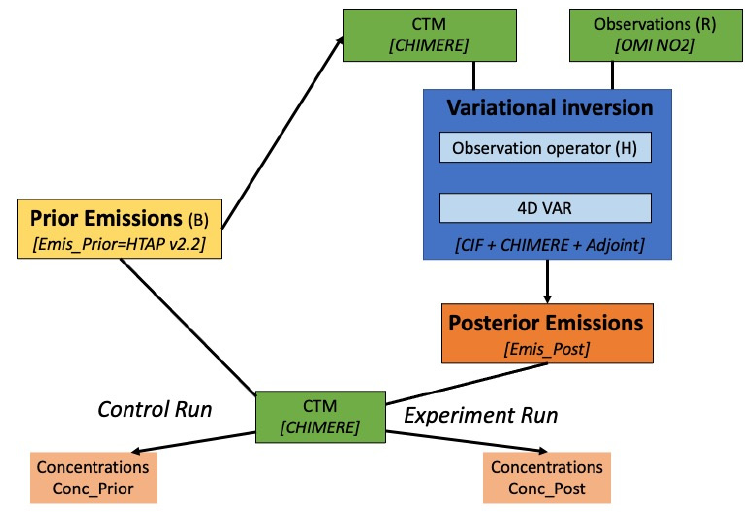
Figure 1. Schematic view of the atmospheric inversion and evaluation in this study.